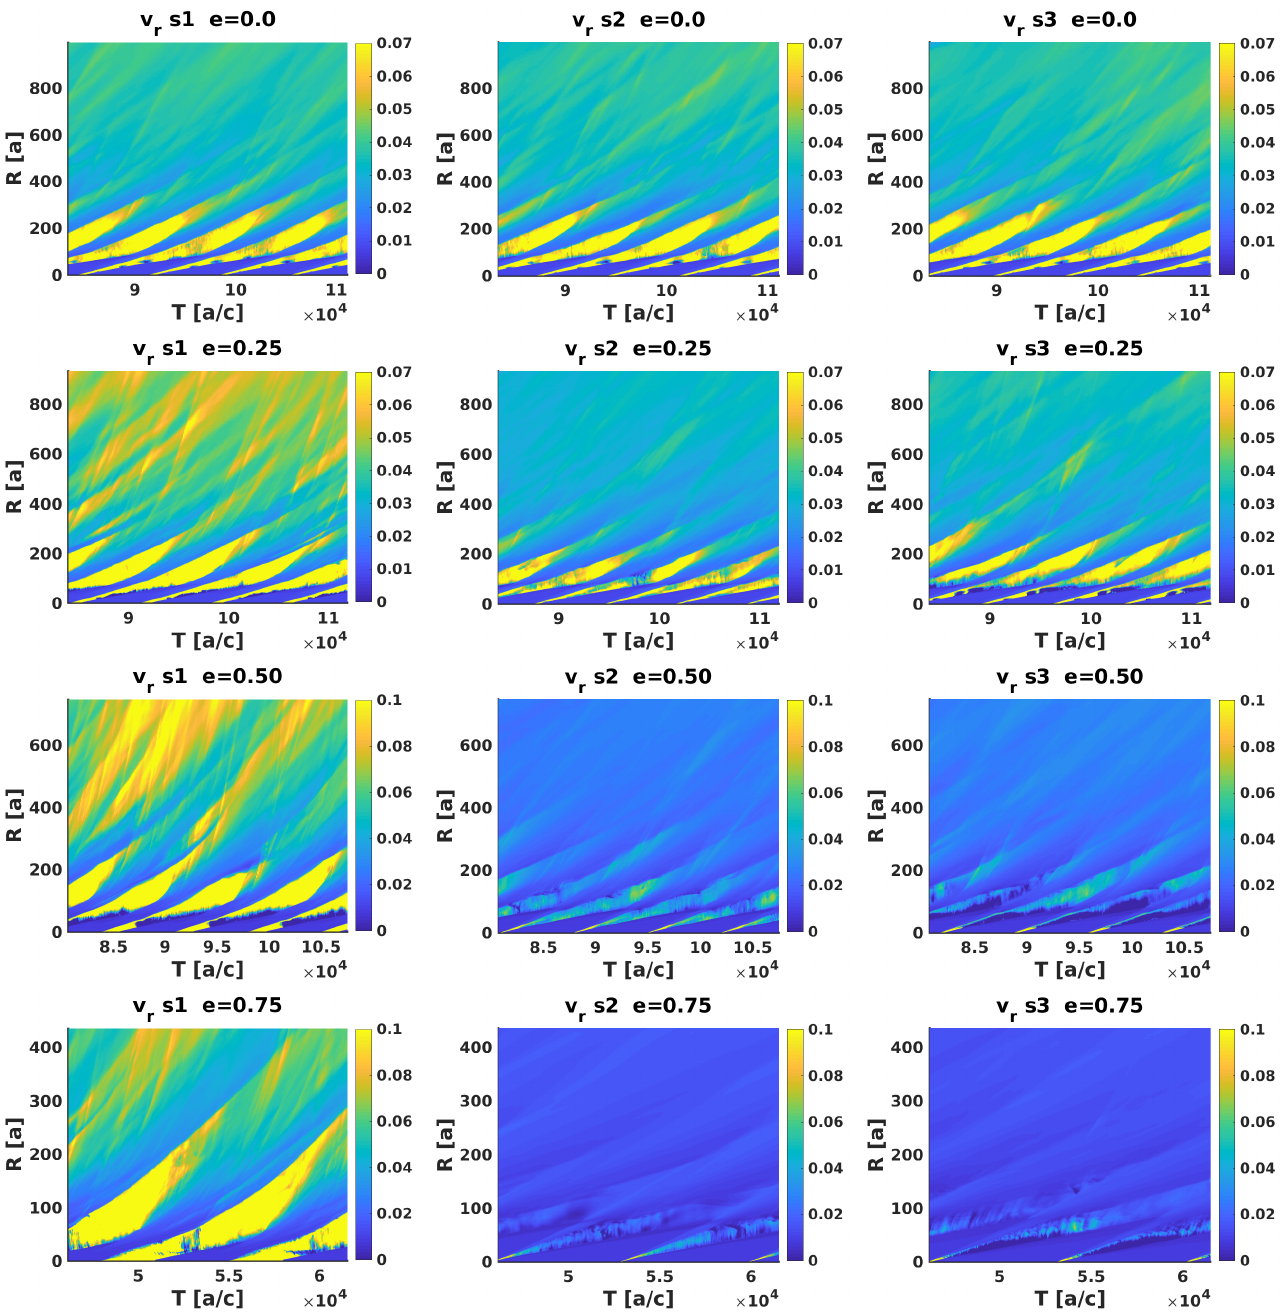
Figure 7. Color map of v r (in light speed units) , averaged over sectors s1, s2 and s3, in the R ( y -axis) versus T ( x -axis) plane. Rows from top to bottom correspond to e = 0, 0.25, 0.5, and 0.75, and columns from left to right to s1, s2, and